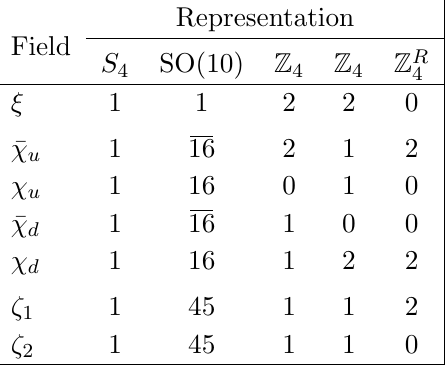
Table 5 . Messengers involved in doublet-triplet